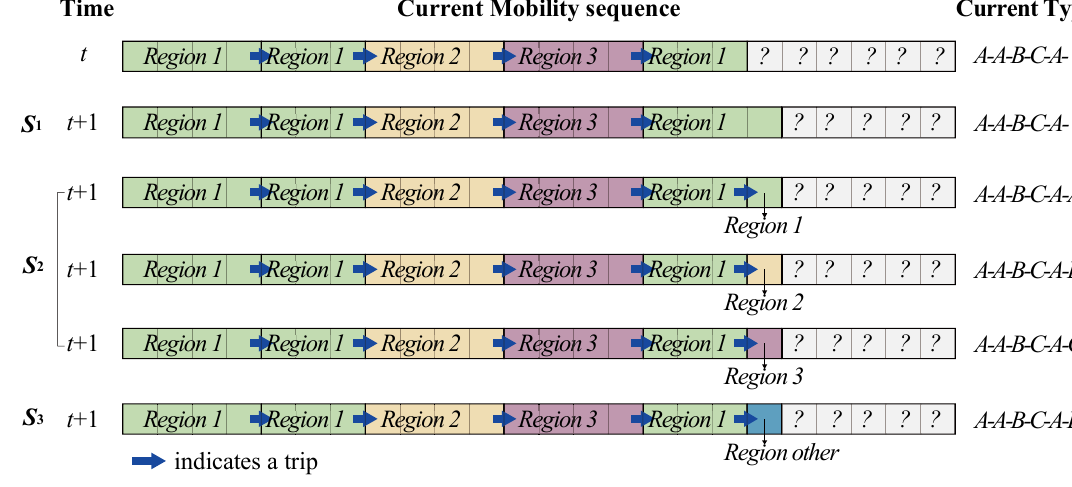
Figure 7. An example about three types of next statuses.